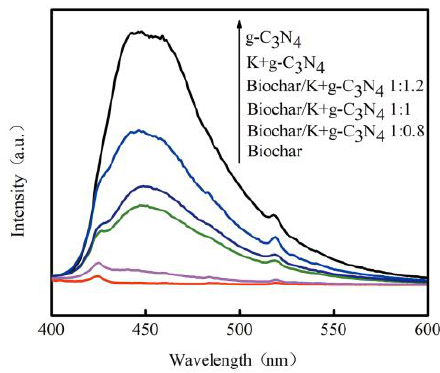
Figure 5. Photoluminescence (PL) spectra of biochar, g-C 3 N 4 , K-doped g-C 3 N 4 and biochar-supported K-doped g-C 3 N 4 .